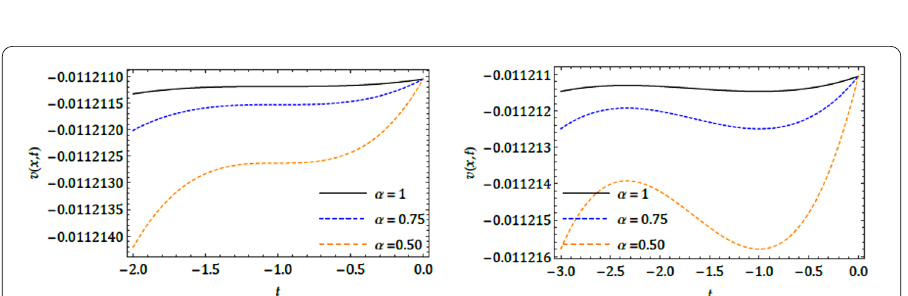
Figure 7 (cid:2) -curves drown for u ( x , t ) at n = 1 (left) and n = 2 (right) with different α when ω = 0.005, (cid:13) = 0.1, c = 10, x = 1 and t = 0.01 for Example 6.1